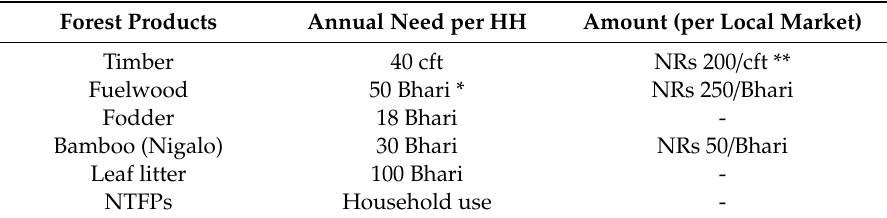
Table 3. Benefits received by the